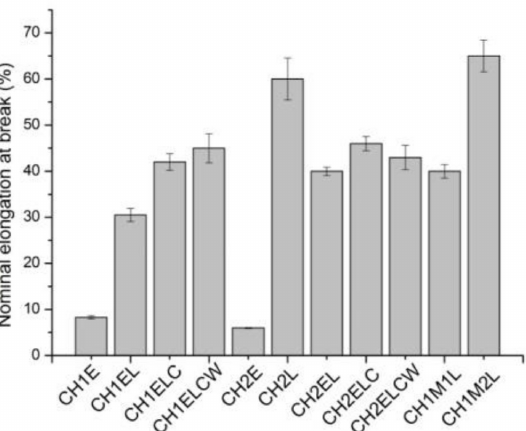
Figure 7. Nominal elongation at break for chitosan/starch-based